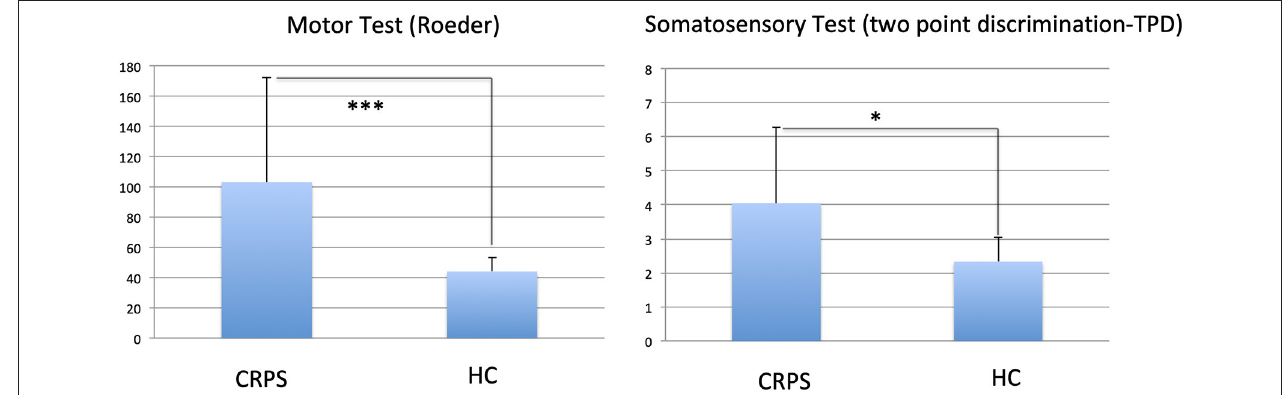
FIGURE 1 | Comparison of motor (Roeder Test) and somatosensory (two point discrimination TPD) tests between CRPS patients and healthy controls (HC); stars indicate p-value of differences; ***0.001; *0.05. Larger values indicate lower performance.